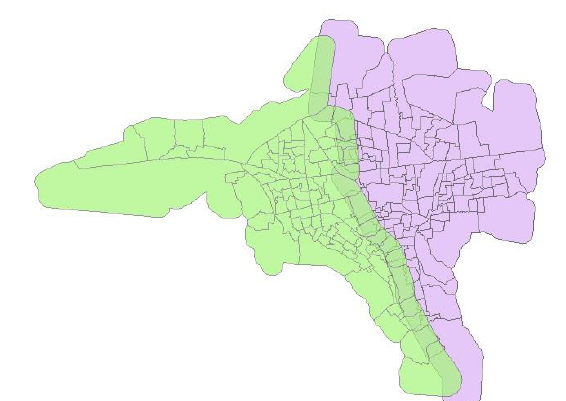
Figure 4. The map of Gorgan’s census districts based on the proposed